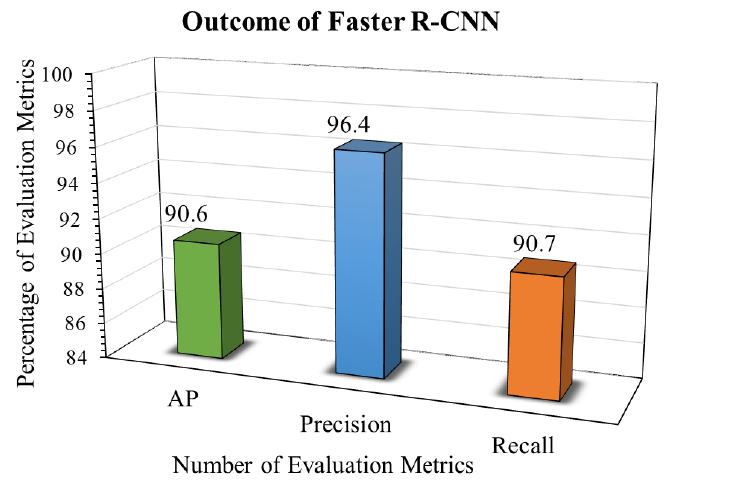
Figure 12. Result of evaluation metrics for target detection based on UAV